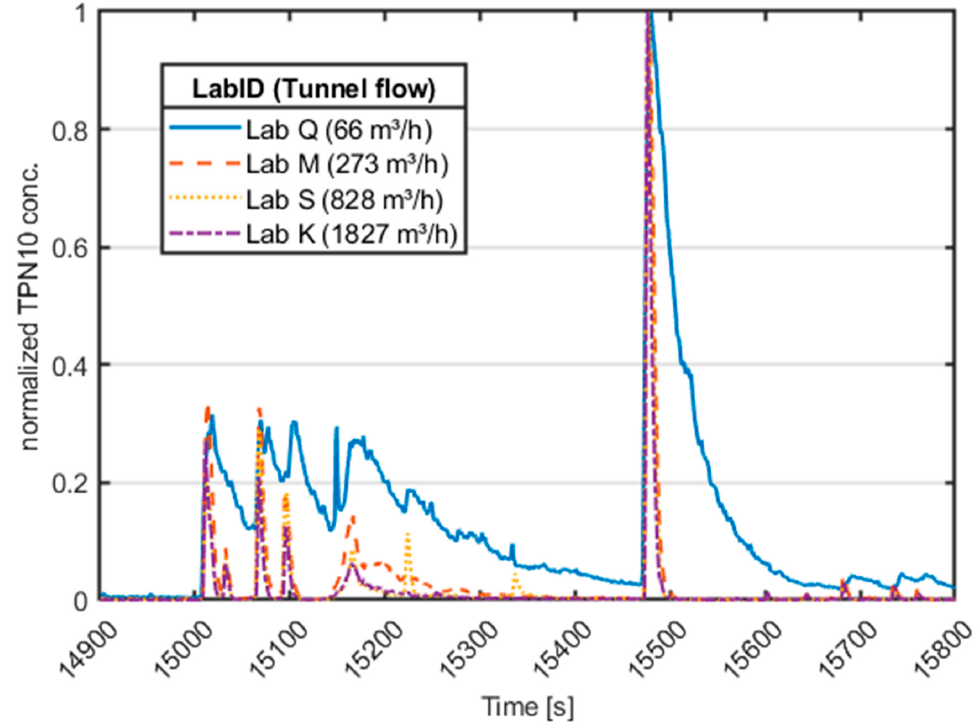
Figure 3. Normalised TPN concentration for Br1Fa for different labs using a wide range of tunnel flow rates from 66 to 1827 m³/h.